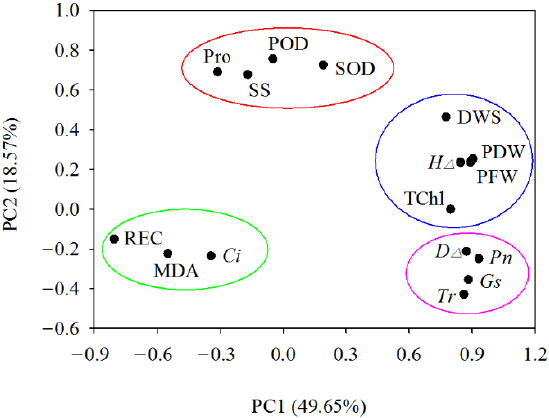
Figure 8. Principal component analysis of walnut genotypes under different salt concentrations. Drawing a scatterplot with PC1 as the X-axis and PC2 as the Y-axis, four naturally segregating groups were formed. Abbreviations of the corresponding indicators are shown in Figures 2–7.